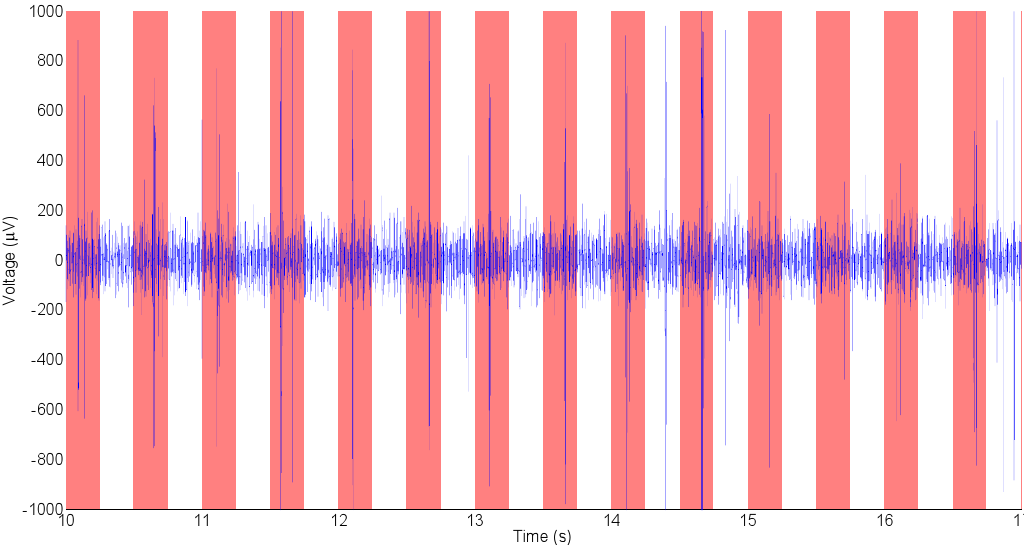
Figure 7. Neural recording from the audio cortex of a guinea pig taken with a silicon-based neural probe, the red bars indicate where auditory stimulus was